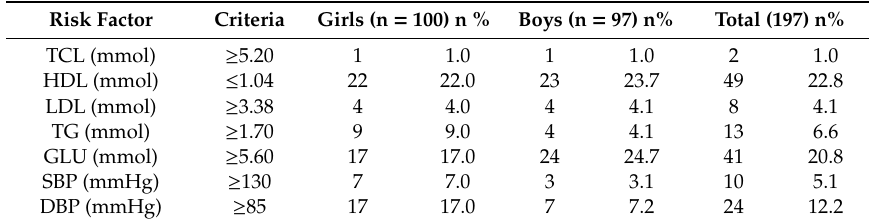
Table 2. Prevalence of CVD risk abnormalities by sex (n =